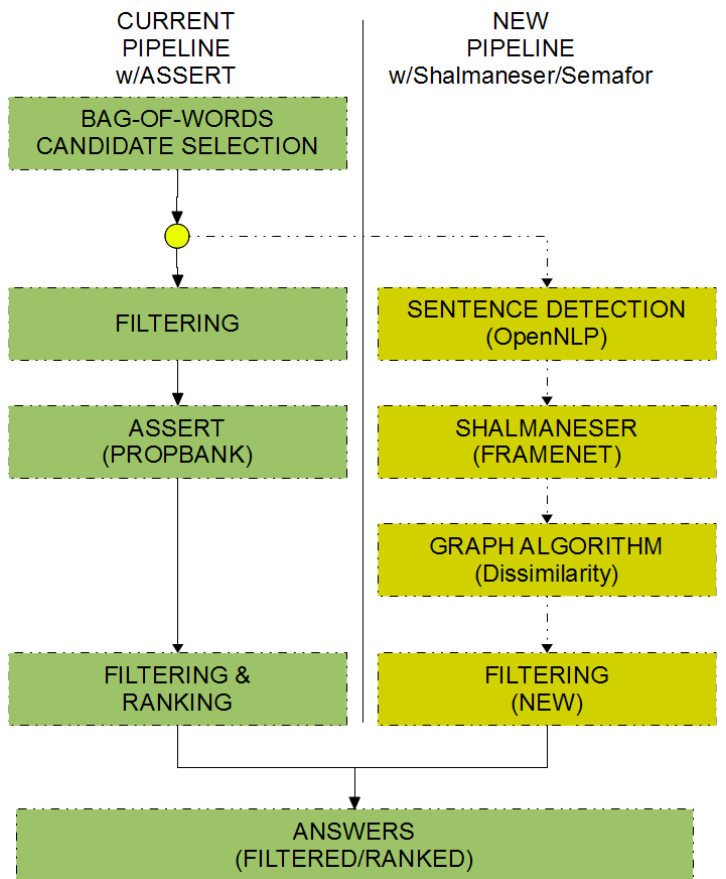
Figure 9 . Alternative pipeline based on